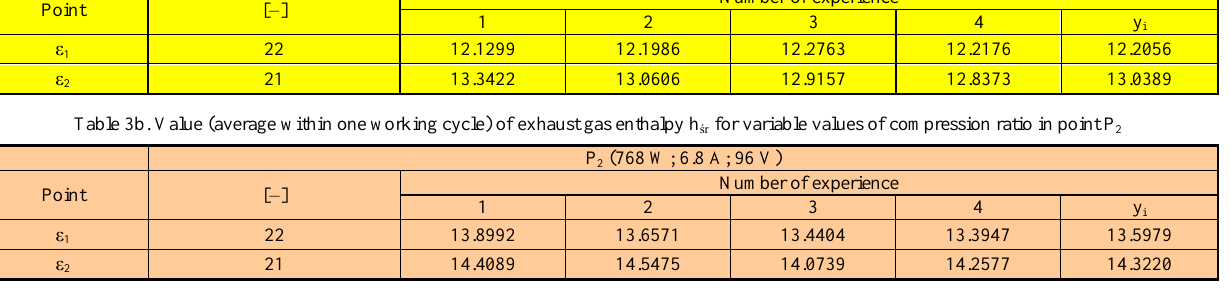
Table 3c. Value (average within one working cycle) of exhaust gas enthalpy h śr for variable values of compression ratio in point P 3